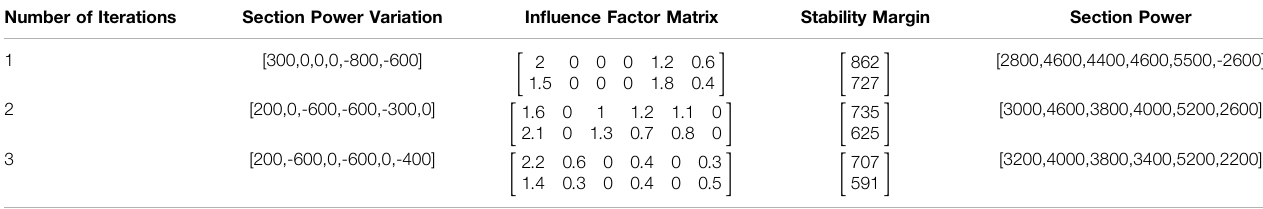
TABLE 2 | Key parameters during the iterative calculation process(Unit:MW). Number of Iterations Section Power Variation In fl uence Factor Matrix